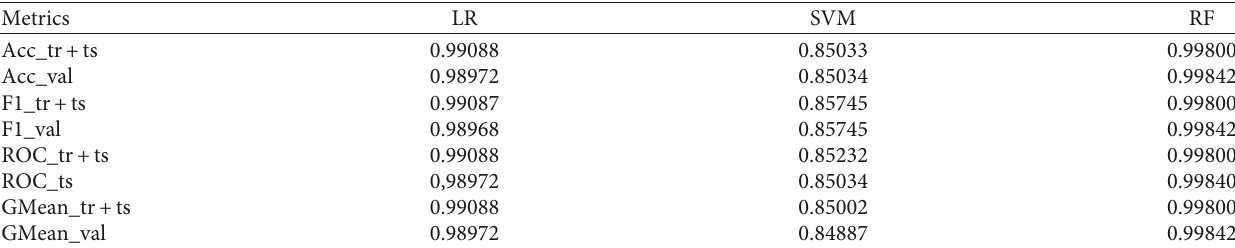
Table 17: For quoting interactions from April 12 until April 22 in 2021, utilizing the similarities between nodes, performance of the LR, SVM, and RF models.